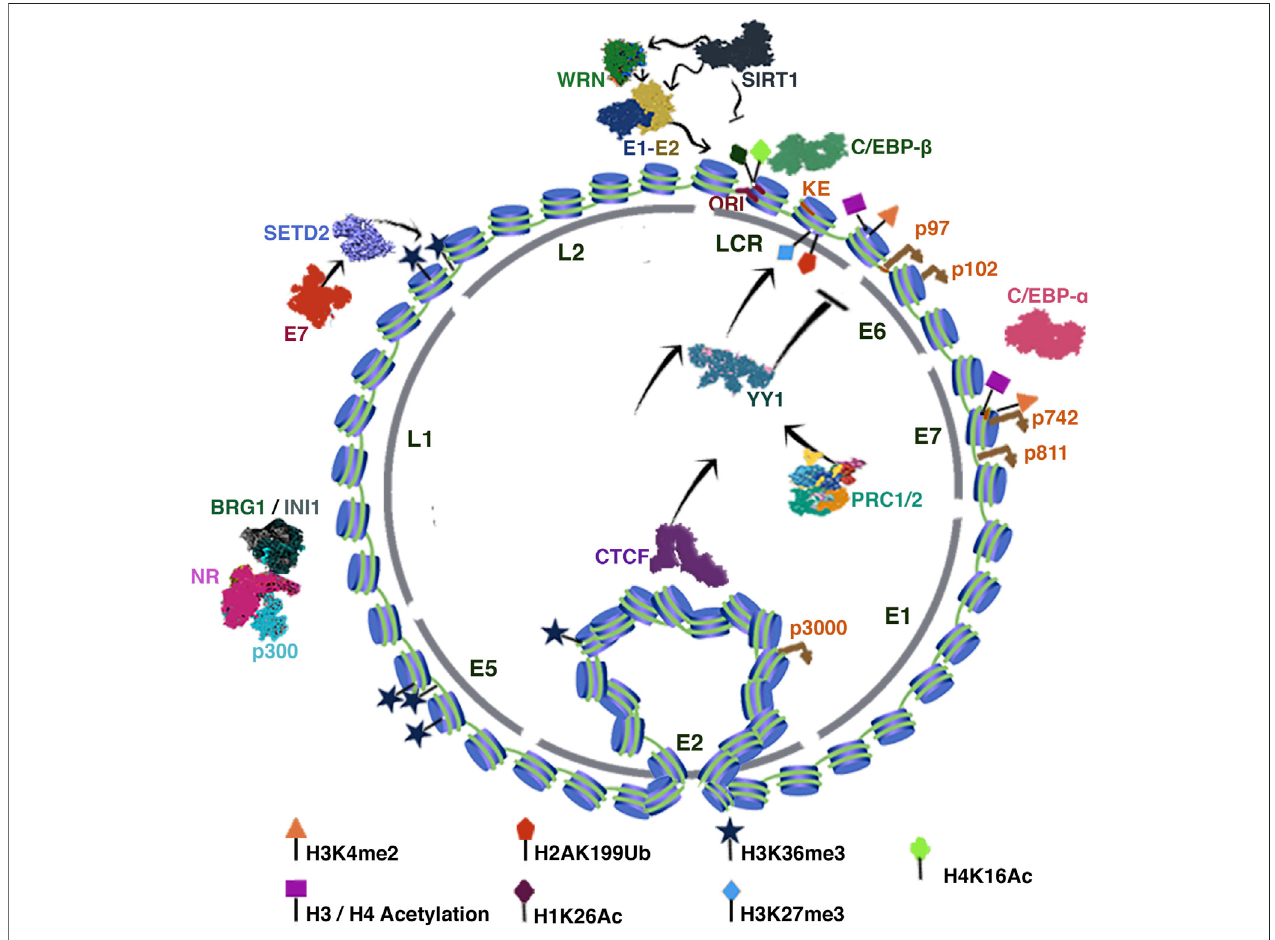
FIGURE 2 | HPV Chromatin. The fi gure illustrates the HPV chromatin regulation. The inner-circle indicates the distribution of the viral genes. The tags indicate the position of the corresponding chromatin mark. In addition, the characteristic loop between CTCF and the LCR region is illustrated. See text for more